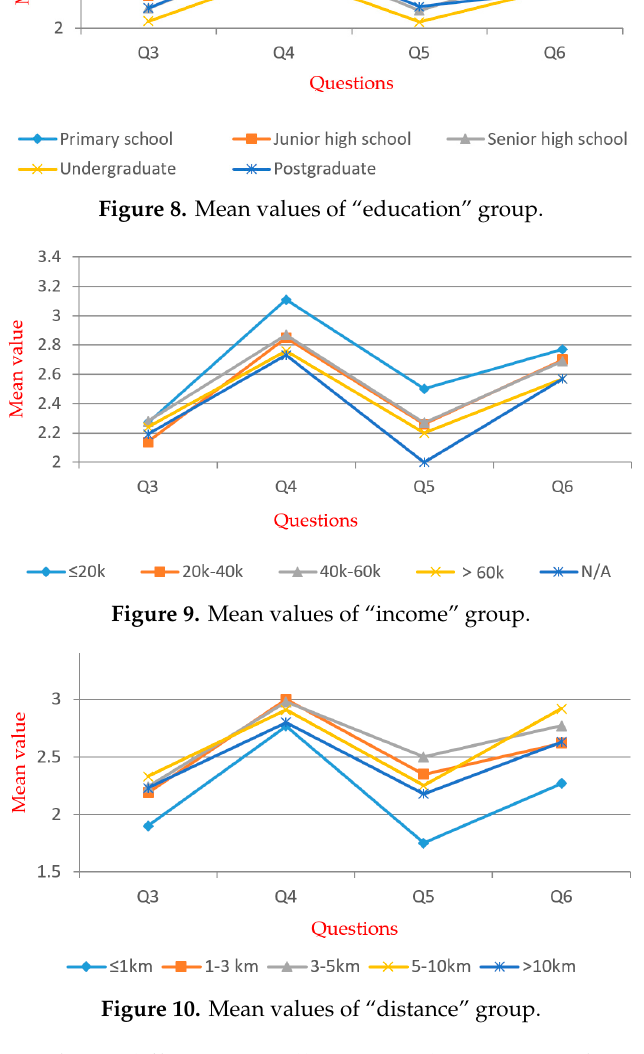
Figure 10. Mean values of “distance” group.